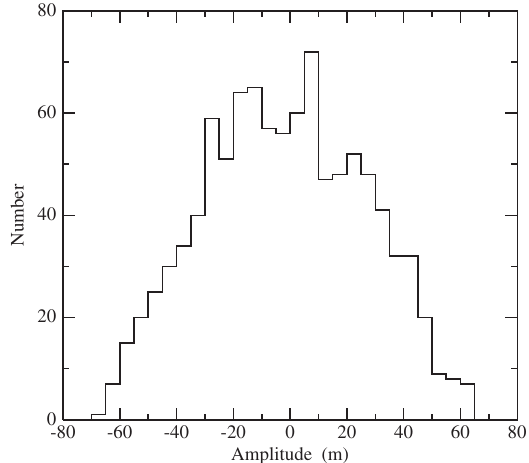
FIG. 15. Distribution of particles in the beam obtained by reproducing the time dependence of Fig. 12 with the amplitude distribution of Fig. 14 and matching that with 1000 tracks following the same amplitude distribution.